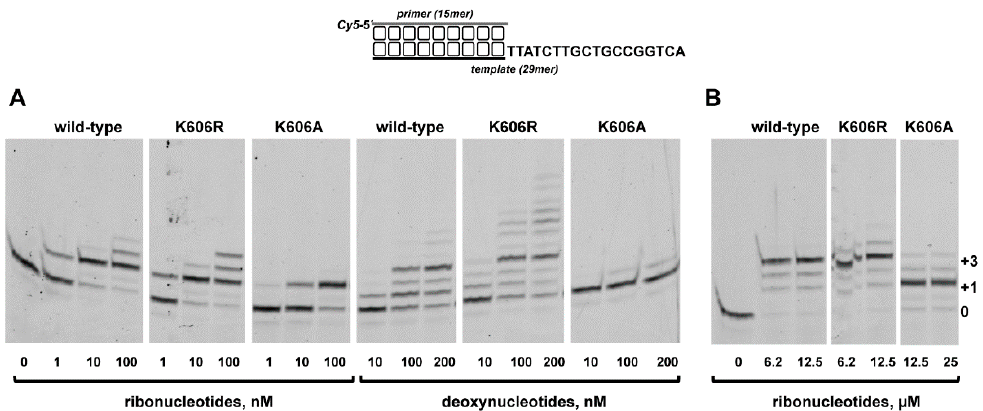
Figure 5. Nucleotide incorporation by Pa -PolDom wild-type and mutants K606R and K606A. The assays were performed as described in Materials and Methods, using 5 nM of the primer/template substrate depicted at top, 200 nM of either the wild-type or the specified Pa -PolDom mutant. The assay was performed in the presence of the indicated nanomolar ( A ) and micromolar ( B ) range of either dNTPs or NTPs . Samples were incubated at 30 °C for 5 min, products were resolved by denaturing PAGE and further visualized using a Typhoon 9410 scanner (GE Healthcare).